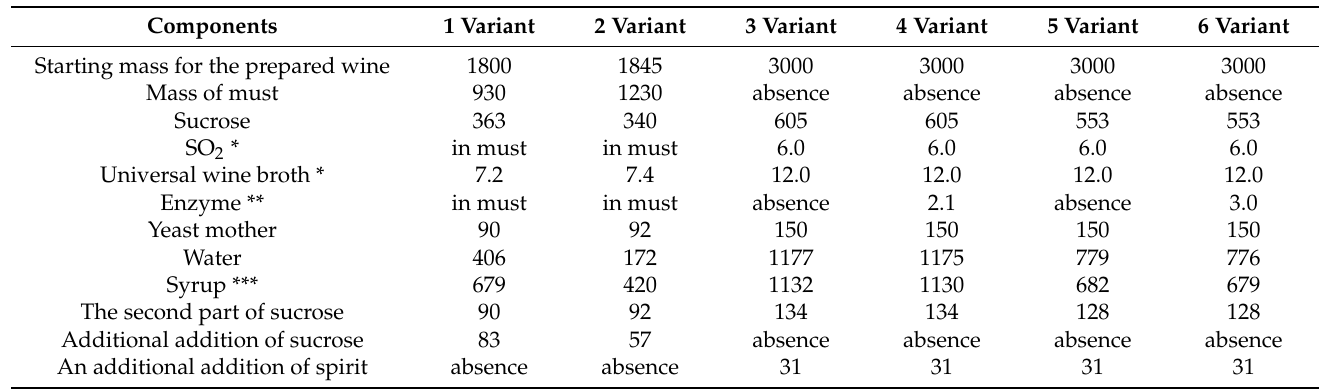
Table A1. The recipe composition of individual variants of the prepared wine in grams.